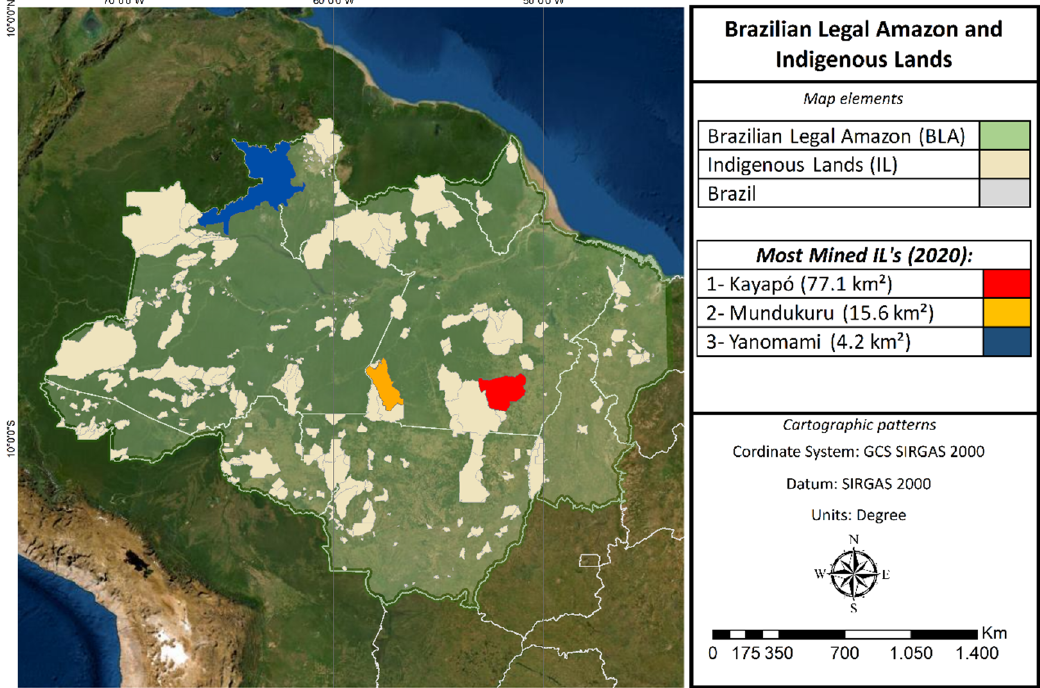
Figure 1. Location of the study area: the Indigenous Lands (ILs) within the Brazilian Legal Amazon (BLA). The three ILs that concentrated most of the mining activity in 2020 are represented by the red (Kayapó), yellow (Munduruku), and blue (Yanomami) colors.